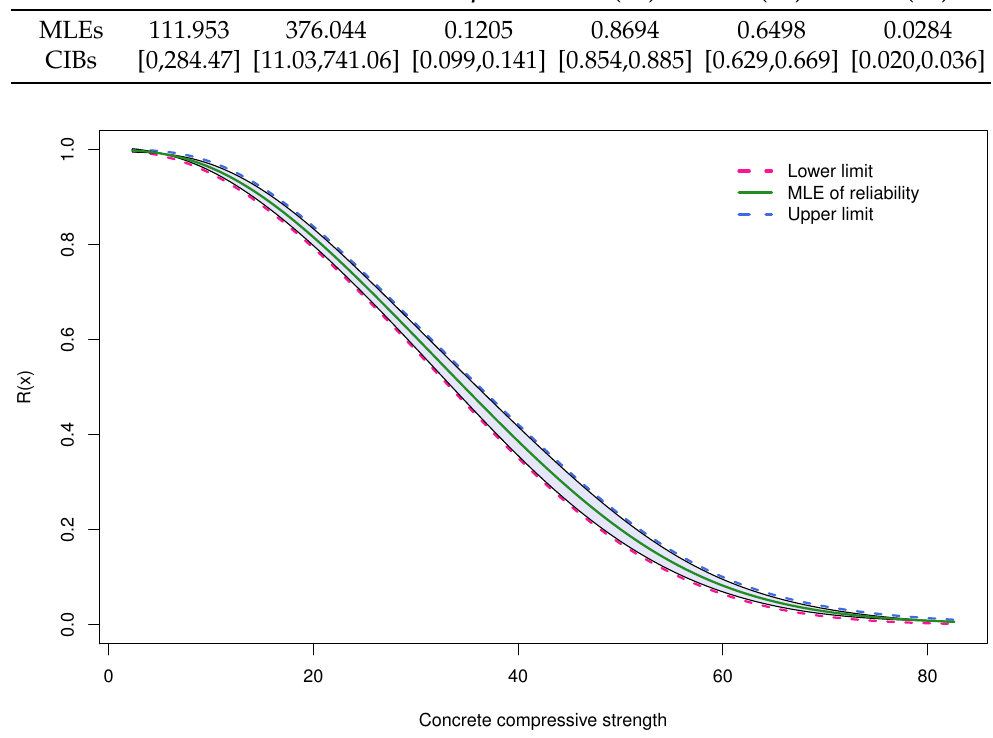
Figure 6. The ACIs of R ( x ) for the concrete compressive strength